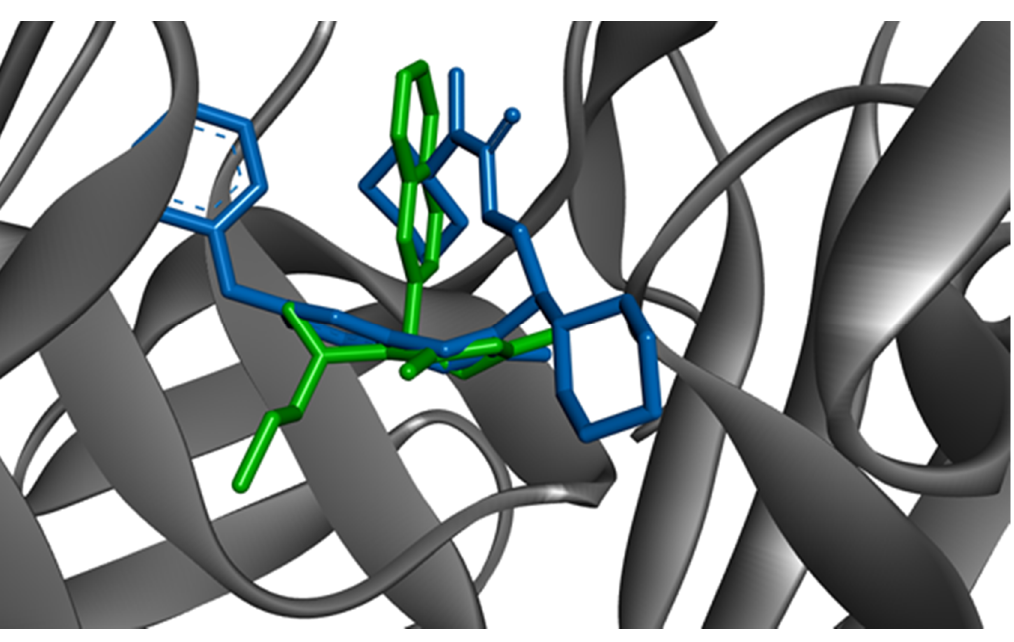
Table 2. Calculated relative binding energies and experimental IC 50 .